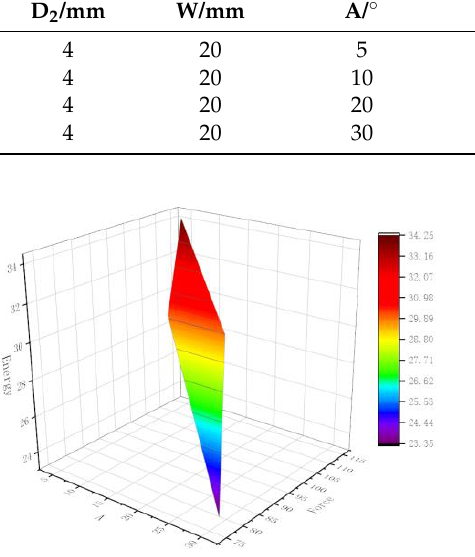
Figure 11. Three-dimensional figure of